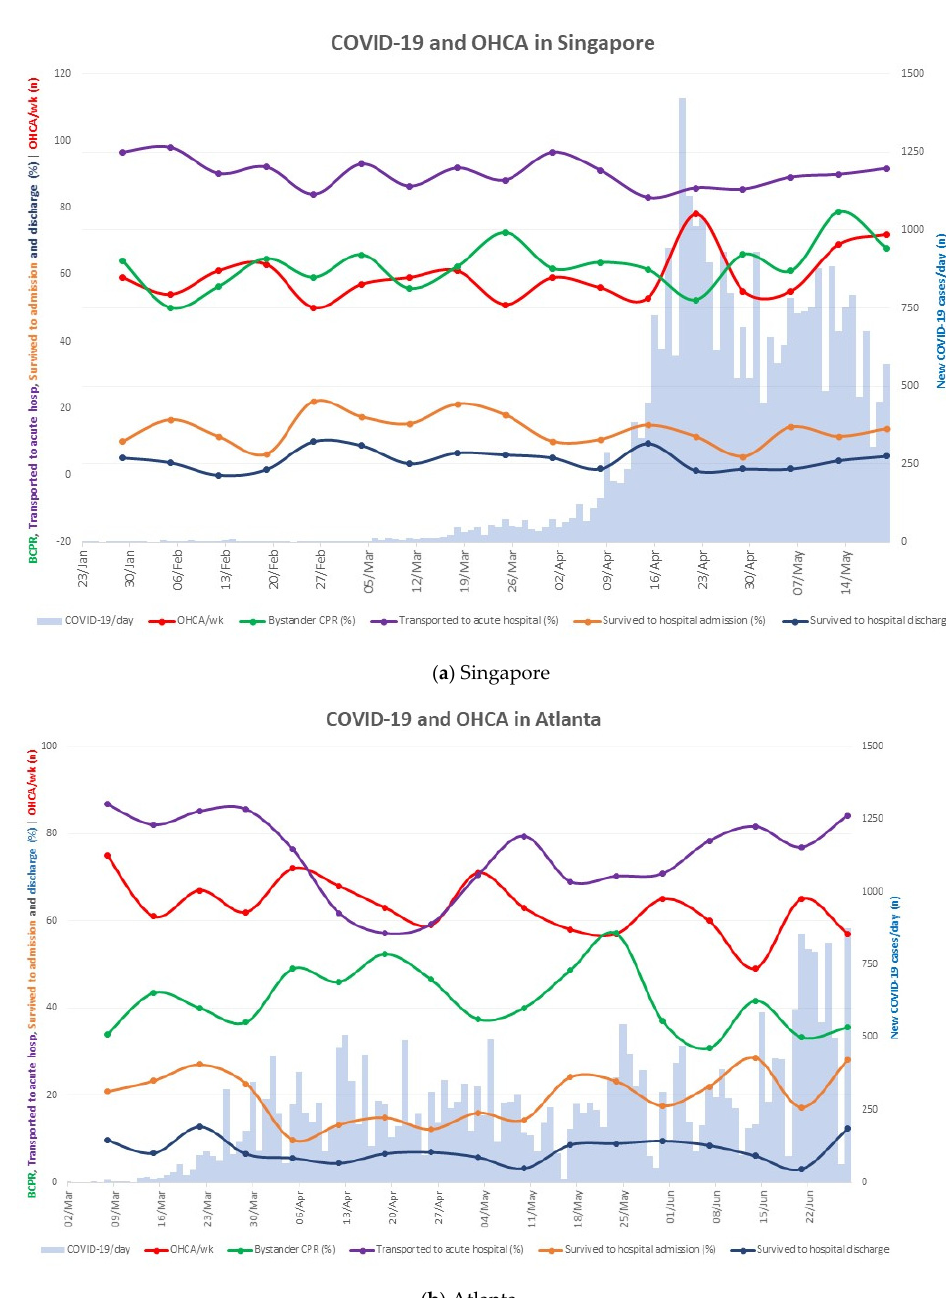
Figure 2. COVID-19 and OHCA in Singapore and Atlanta. Pre-hospital interventions for and outcome of OHCA against a backdrop of COVID-19 pandemic in ( a ) Singapore, and ( b ) Atlanta. X-axis depicts the first 17 weeks (119 days) of the pandemic, starting on 23 January 2020 in Singapore and 2 March 2020 in Atlanta. Y-axis on the left depicts the weekly average of OHCA (n), bystander CPR (%), OHCA transported to acute hospitals (%), survival to hospital admission (%) and survival to hospital discharge (%). Y-axis on the right depicts the daily number of new COVID-19 cases. Abbreviations: COVID-19, coronavirus disease 2019; OHCA, out-of-hospital cardiac arrest; BCPR, bystander cardiopulmonary resuscitation.